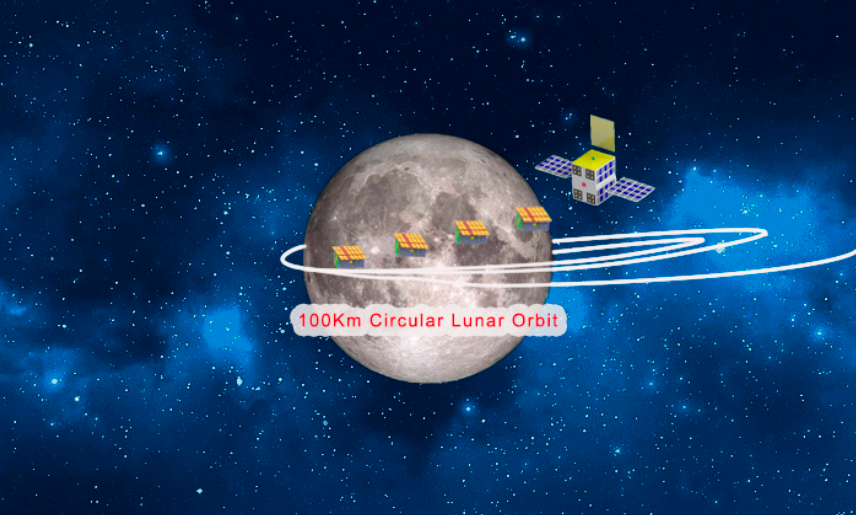
Figure 6. LOCI Low Lunar Orbit insertion.